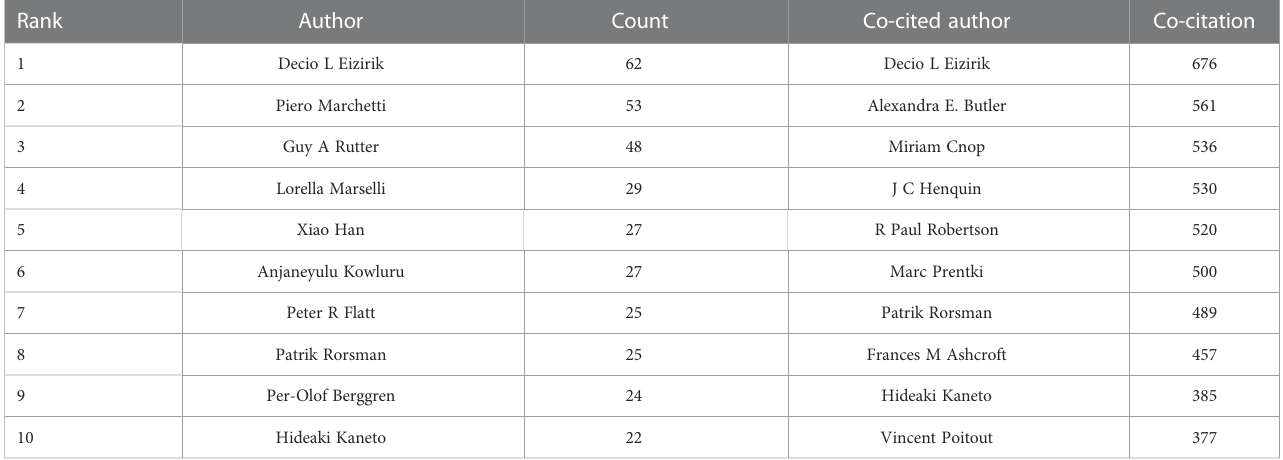
TABLE 2 Top 10 authors and co-cited authors related to beta-cell research.